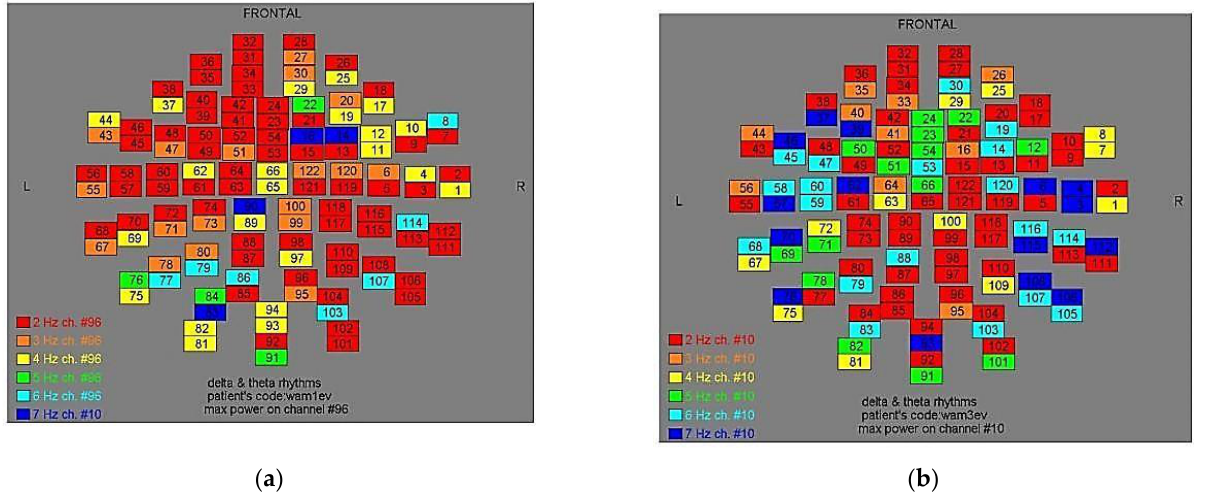
Figure 9. Dominant frequency color mapping for patient #8, before ( a ) and after ( b ) magnetic stimulation.